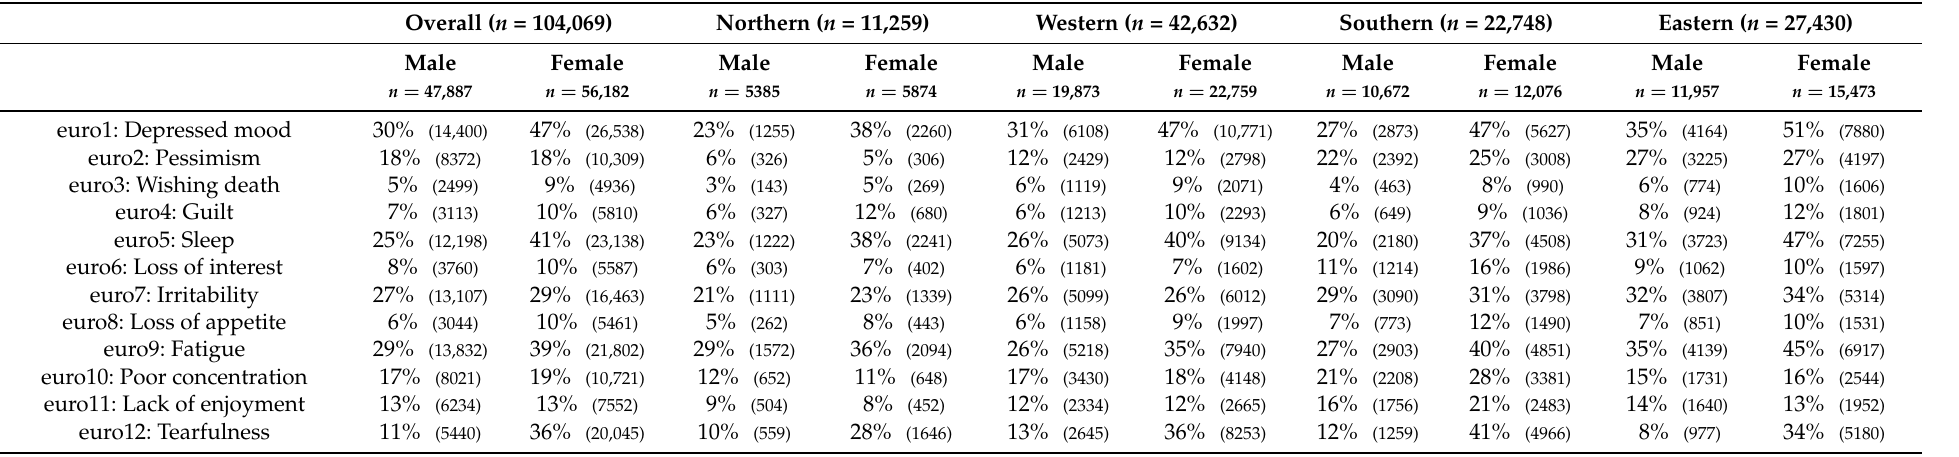
Table A2. Descriptive statistics for the prevalence of symptoms. Numbers after percentages are frequencies, n indicates the sample size. Countries were categorized into four regions: Northern Europe (Denmark and Sweden), Western Europe (Austria, Germany, France, the Netherlands, Switzerland, Belgium, Ireland and Luxembourg), Southern Europe (Spain, Italy, Greece and Portugal) and Eastern Europe (Czech Republic, Poland, Hungary, Slovenia, Estonia and